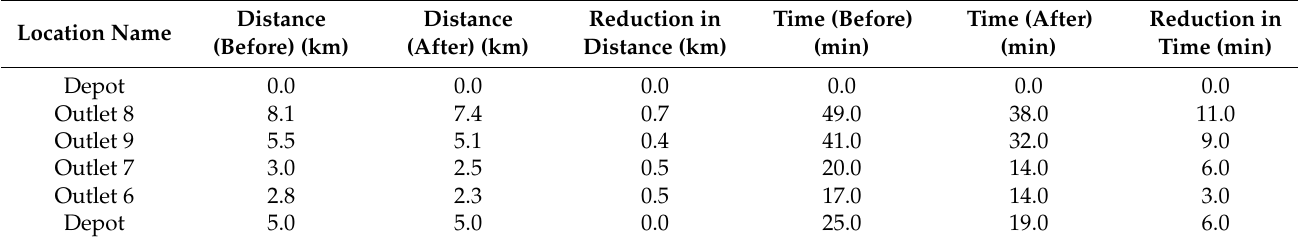
Table 4. Traveling distance before and after using the Intelligent Route Optimizer application for vehicle 2.